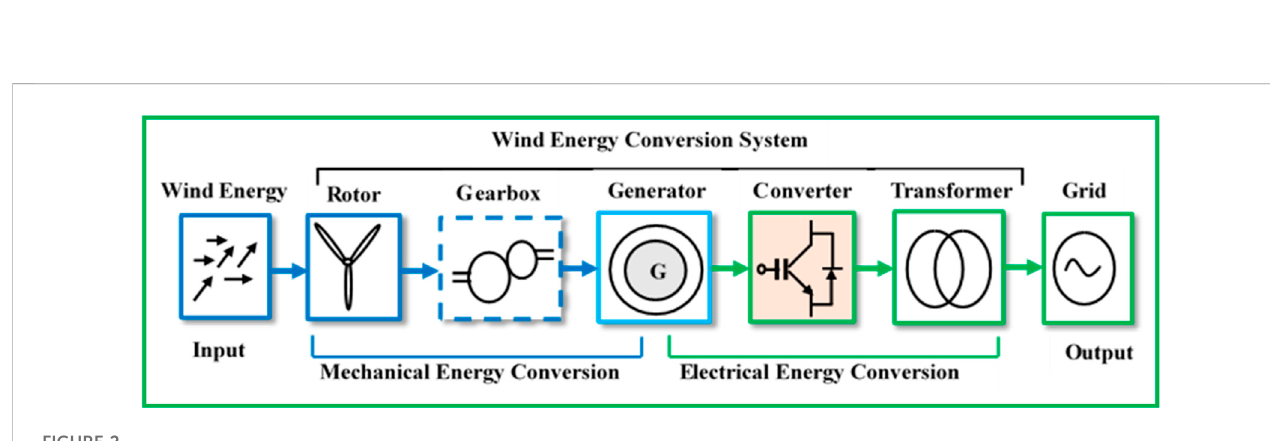
FIGURE 2 Energy conversion levels in a modern wind energy conversion